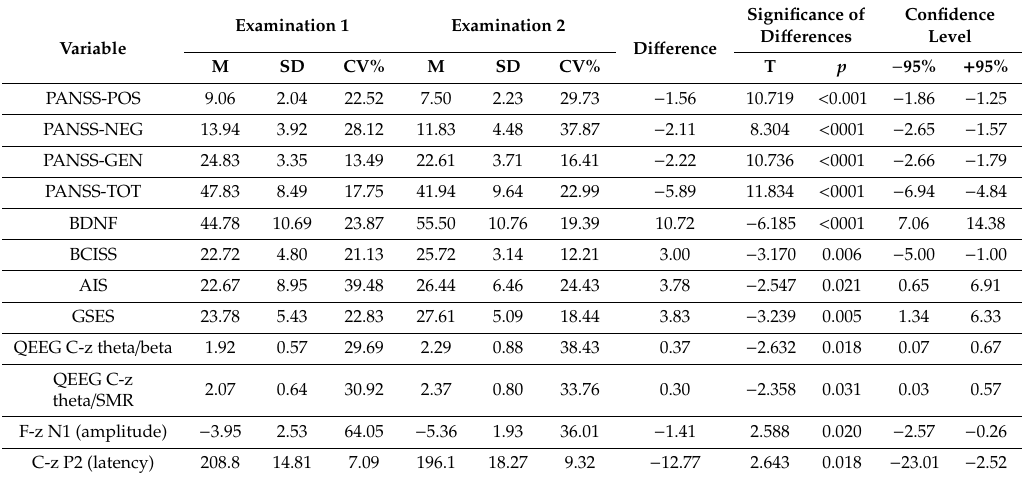
Table 1. Comparative analysis of results obtained before therapy (Examination 1) and after therapy (Examination 2); latency (latency time in ms), and amplitude (mv, peak-to-peak).